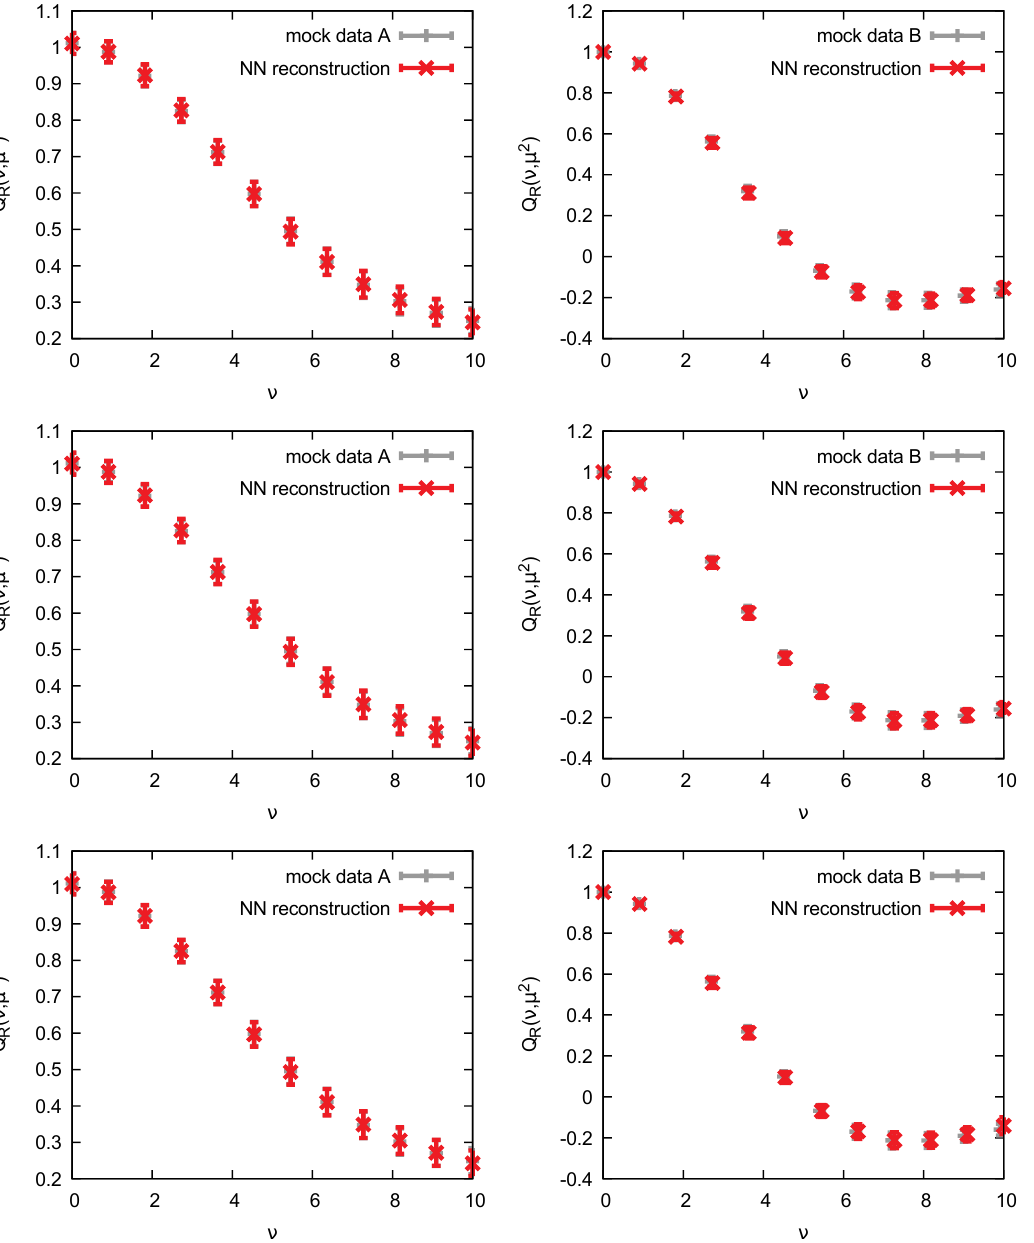
Figure 10 . The genetically trained neural nets. The grey points are the original data while the red points are the ones reconstructed by the NN. The left column is with NNPDF data. The right column is with modi(cid:12)ed data. The (cid:12)rst row has a network geometry of 1-3-1. The second row